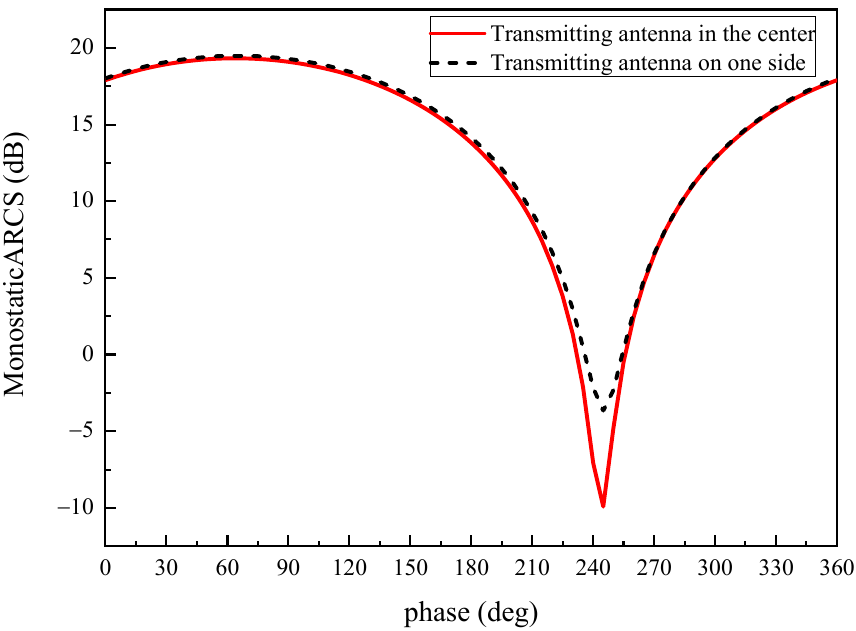
Figure 7. The Minimum ARCS of the target on the direction the aircraft is facing when the echo cancellation antenna is placed on one side or in the center.